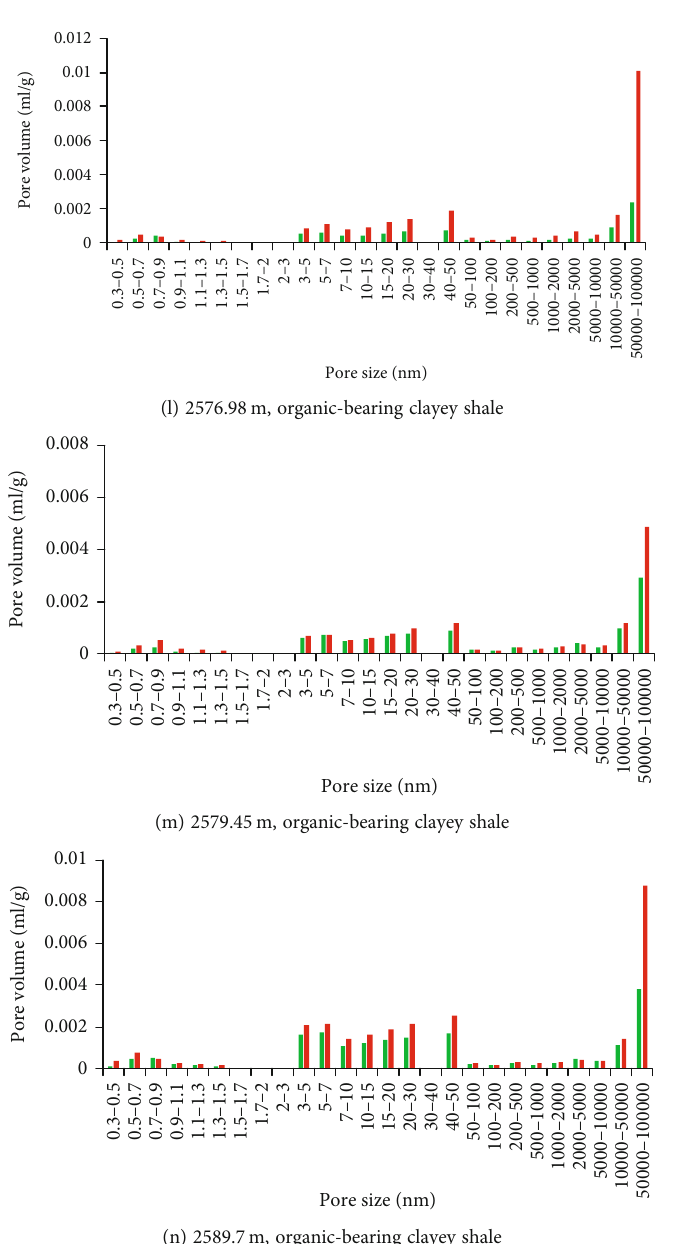
Figure 4: Pore volume features based on the joint characterization for full-scale pore size of di ff erent shale samples in TY1 well. Green: pore volume data of shale samples before the extraction of shale oil; Red: pore volume data of shale samples after the extraction of shale